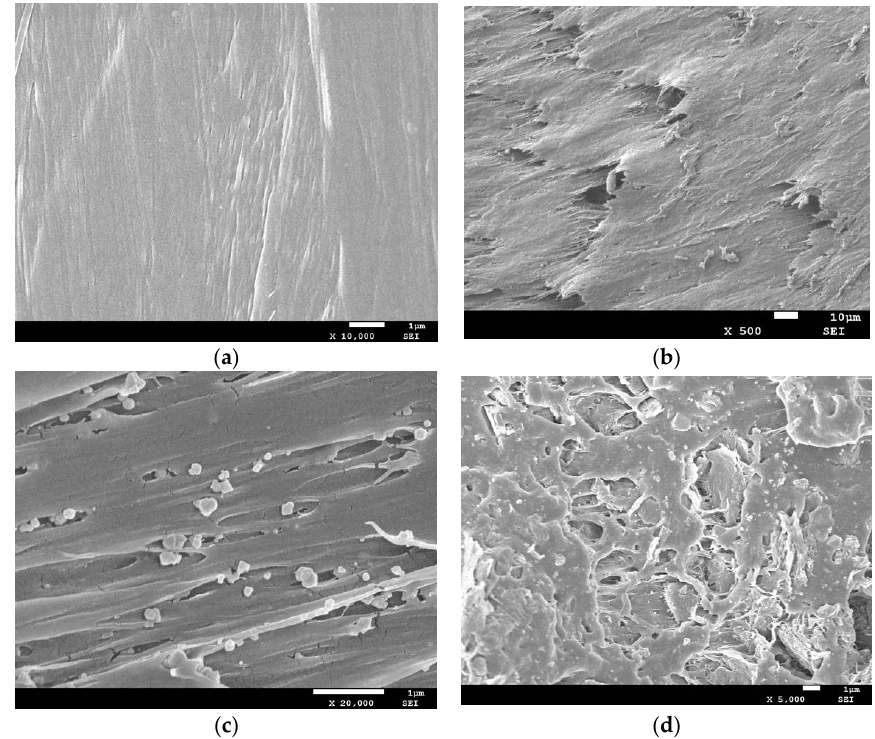
Figure 11. SEM cross-section of pure PLA and composite absorbers with different absorbing agent composition. ( a ) Pure PLA absorber; ( b ) 5 wt% graphene/PLA composite absorber; ( c )